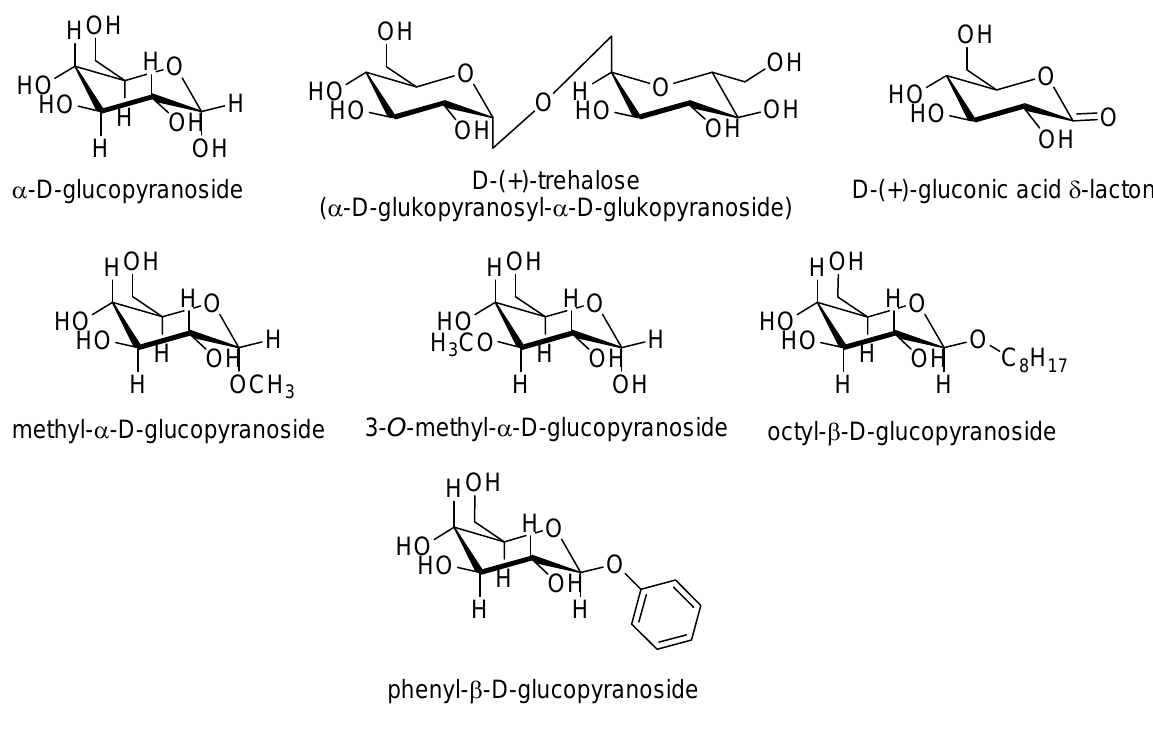
Figure 4. NIR spectra of D -glucopyranose derivatives. ( α - D -glucose: Glu, D -(+)-trehalose, D - (+)-gluconic acid δ -lactone: Glu acid lactone, methyl- α - D -glucopyranoside: Me-glu, 3- O -methyl- α - octyl- β - D -glucopyranoside: Octyl-glu, phenyl- β - D